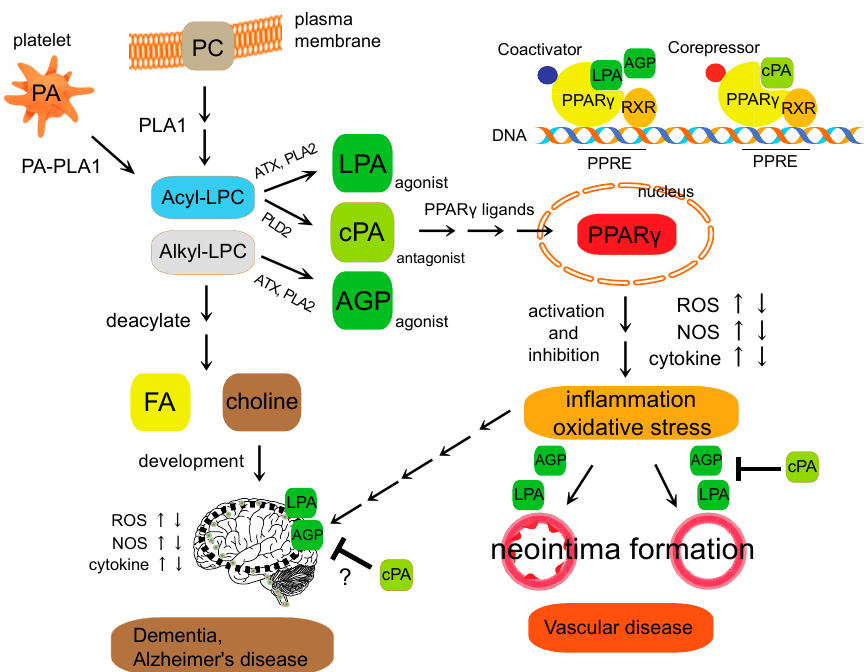
Figure 1. Schematic diagram of lysophospholipid-mediated PPAR γ signaling. Lysophosphatidylcholine (LPC) is a bioactive phospholipid generated primarily by the action of phospholipase A2 (PLA2) enzymes on the plasma membrane. After cellular uptake, free LPC is reacylated yielding PC or deacylated yielding FA and choline. LPA and AGP are generated intracellularly in a stimulus-coupled manner by the ATX or PLA2 enzyme. cPA is generated intracellularly in a stimulus-coupled manner by the PLD2 enzyme. LPA and AGP induced neointima formation through the activation of PPAR γ , whereas cPA inhibited PPAR γ -mediated arterial wall remodeling in a noninjury infusion model. However, the physiological context of cPA in PPAR γ signaling in brain is still unclear. Imbalance of the PPAR γ agonist-antagonist equilibrium is involved in changes in cellular functions, including ROS generation, NOS and cytokine expression. These endogenous lysophospholipids regulate PPAR γ function required for vascular wall pathologies, and metabolic-related diseases. PPRE (PPAR response element); RXR (retinoid X receptor); ATX